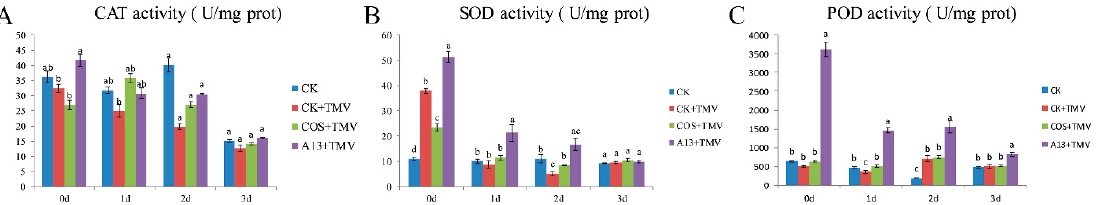
Figure 2. The effect of compound A13 on CAT ( A ), SOD ( B ), and POD ( C ) activity in tobacco leaves. Bars indicate the mean of three replicates with the standard deviations. Different letters on the bars indicate statistically significant differences in average values by one-way ANOVA ( p < 0.05).